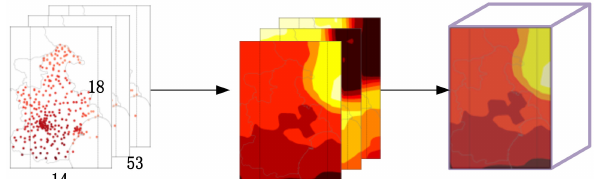
Figure 2. Visualization of observational data. The first column in the figure is the site observation data at 53 time steps. The second column is the grid observation data after inverse distance interpolation. The third column is the 3D tensor obtained by concatenating the tensor in the second column in the time